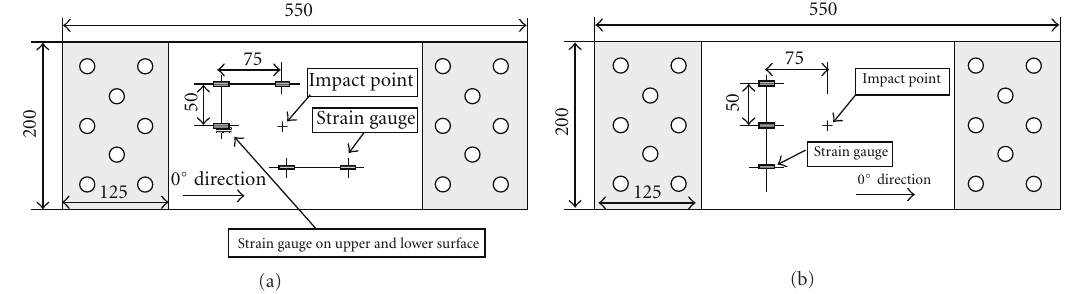
Figure 2: Impact specimen dimensions (in mm) and position of strain gauges for (a) compressive preload and (b) tensile preload.